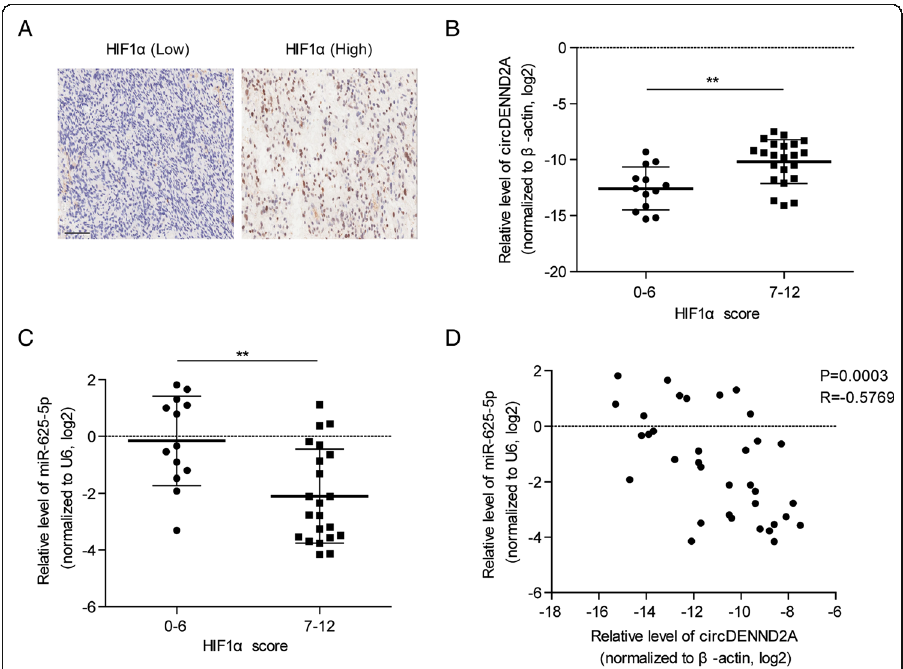
Fig. 5 The circDENND2A/miR-625-5p pathway is related to HIF1 α in glioma tissues. a Representative IHC images of glioma tissues with high or low expression of HIF1 α . b and c Based on the IHC score of HIF1 α , 35 glioma tissues were separated into a high-HIF1 α expression group (IHC score: 0 – 6, n = 22) and a low- expression group (IHC score: 7 – 12, n = 13). The relative levels of circDENND2A ( b ) or miR-625-5p ( c ) in the high- or low-expression group were quantified by qPCR and then individually normalized to β -actin and U6. d Correlation between circDENND2A and miR-625-5p in the 35 glioma tissues. ** p <